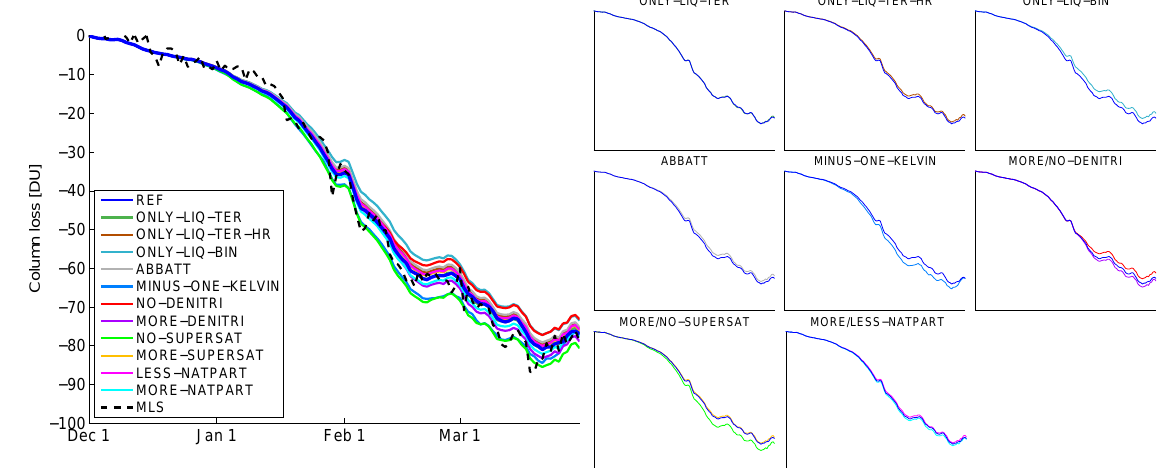
Fig. 10. Vortex-averaged total column ozone loss as a function of time. The different sensitivity runs are represented by different colours. The black dashed line shows the column ozone loss obtained by subtracting the passive ozone tracer of the model from MLS ozone measurements. Vortex average as in Fig. 1. The small plots on the right show only one or two sensitivity runs and the reference run at the same time for